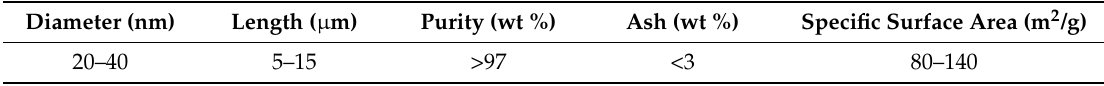
Table 1. Material properties of multi-walled carbon nanotubes